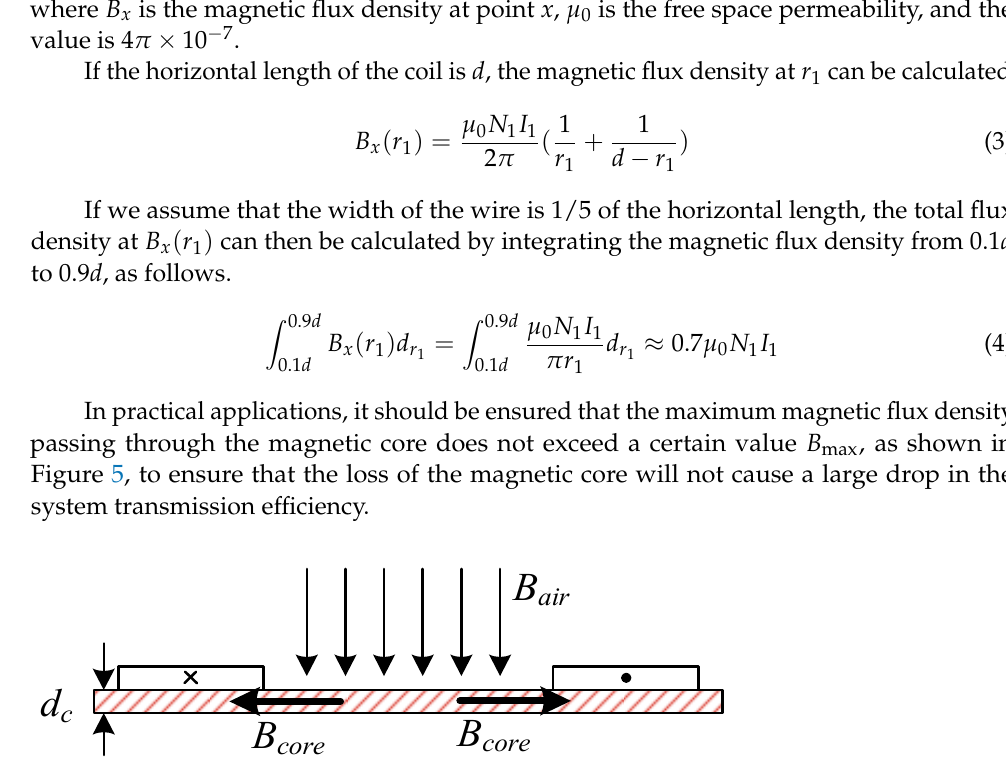
where B x is the magnetic flux density at point x , µ 0 is the free space permeability, and the value is 4 π × 10 − 7 .